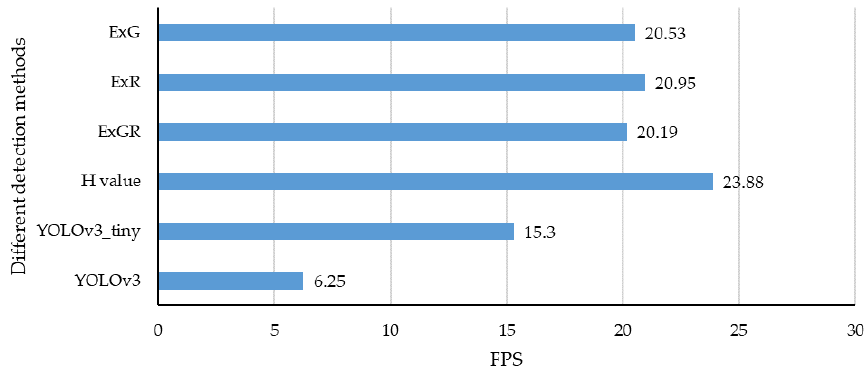
Figure 13. Detection speeds of different detection methods.